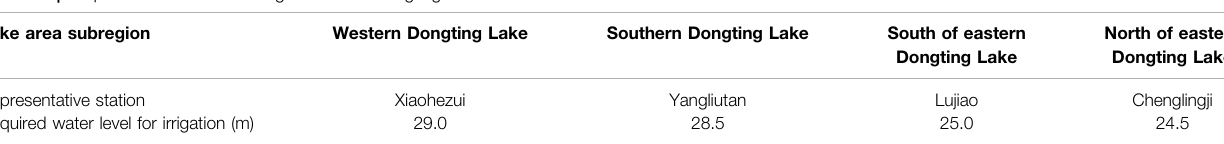
TABLE 5 | Required water levels for irrigation in the Dongting Lake